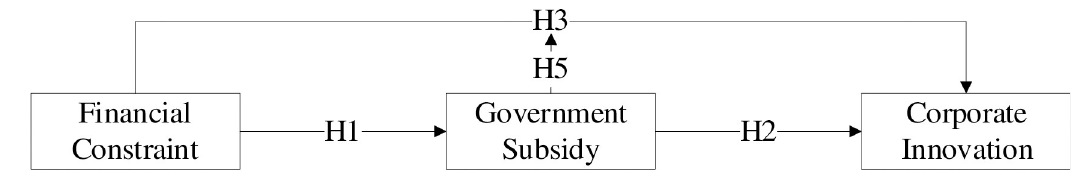
Fig 1. Theoretical